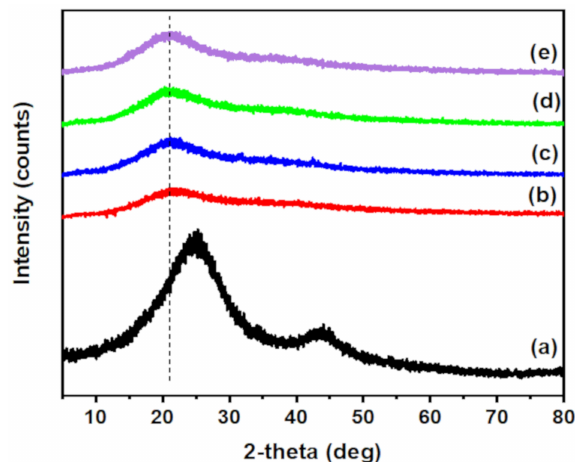
Figure 3. XRD of ( a ) O-ECNFs, ( b ) CT- g -PAA, ( c ) CT- g -PAA / O-ECNFs-0.5 ( d ) CT- g -PAA / O-ECNFs-1.5 ( e ) CT- g -PAA / O-ECNFs-2.